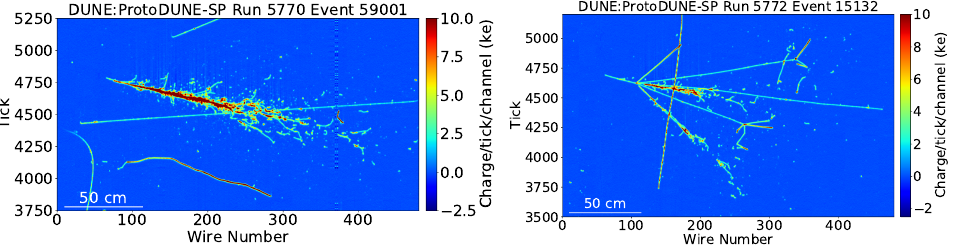
Figure 14. ( Left ): A 6 GeV/c electron candidate. ( Right ): A 6 GeV/c pion candidate